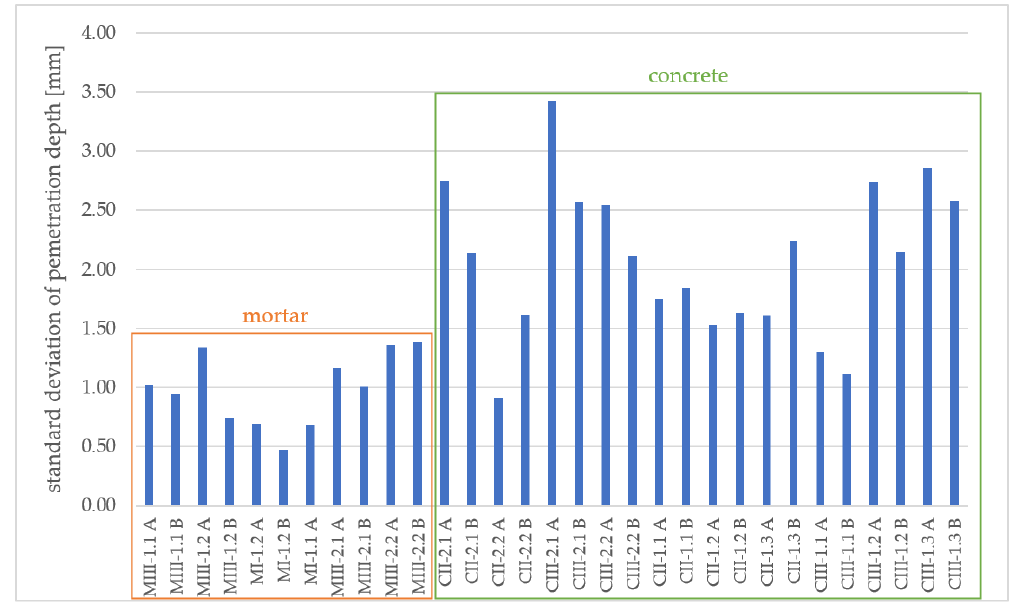
Figure 5. Standard deviation of penetration depth per specimen half (half A and B) measured after spraying AgNO 3 for mortar and concrete samples.